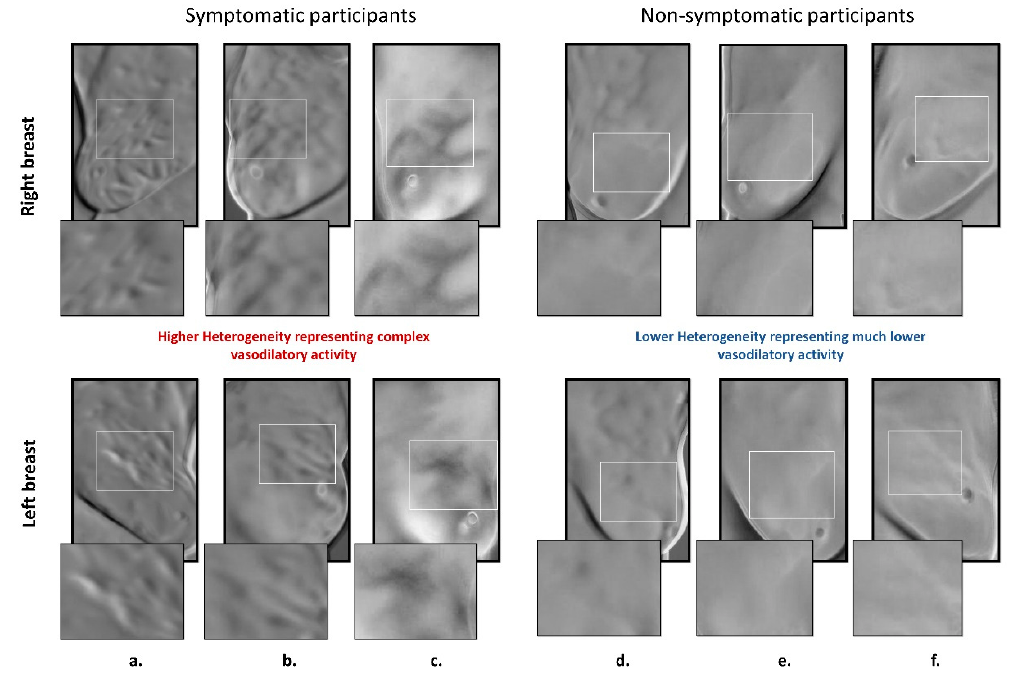
Figure 4. Low-rank approximation of thermal sequence determined using different Sparse PCT (principal component analysis) matrix factorization technique. Each column shows different case, columns ( a – c ) show symptomatic patients (diagnosed by mammography as cancer patients or healthy with symptoms), whereas columns ( d – f ) show the result of methods for healthy